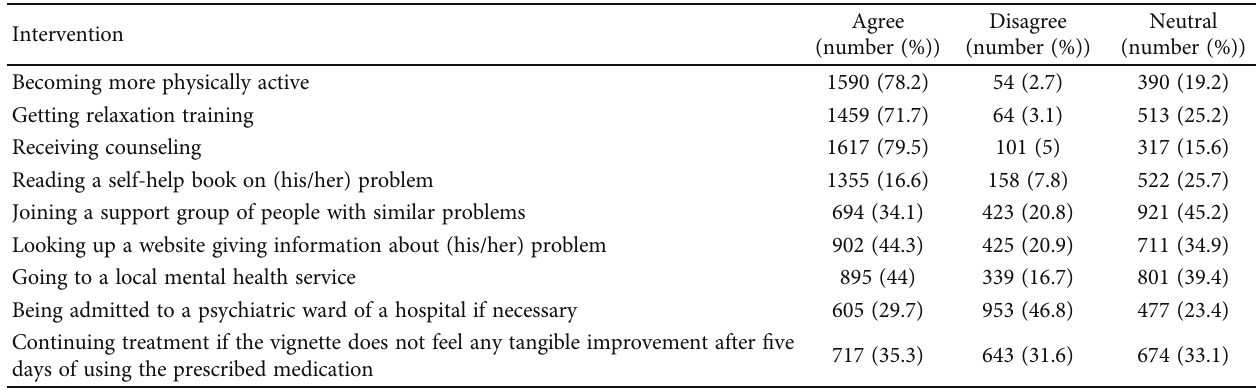
Table 3: Adolescent ’ s beliefs and knowledge about interventions that are likely to be helpful for